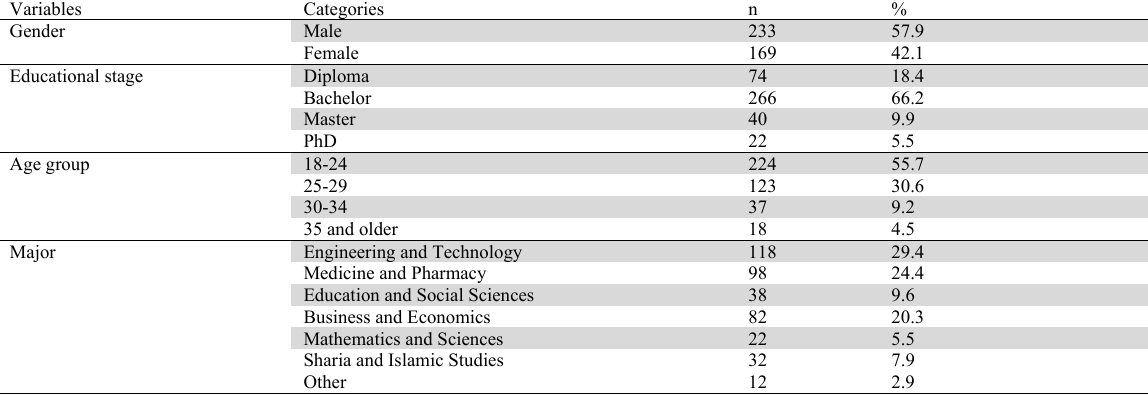
Demographic profile of respondents ( N= 402